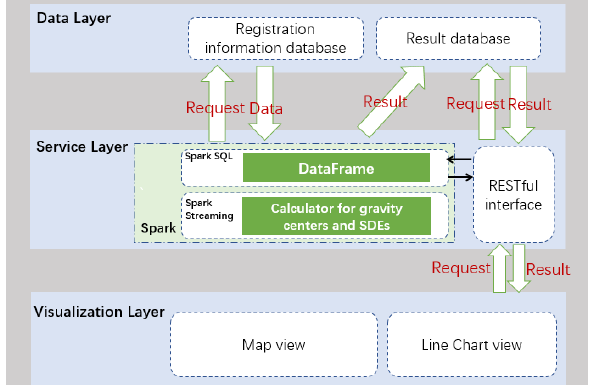
Figure 1. The structure of the proposed visualization framework